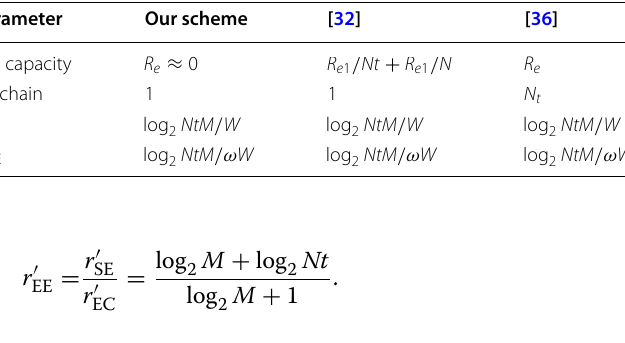
Table 4 Comparison of conventional SM security